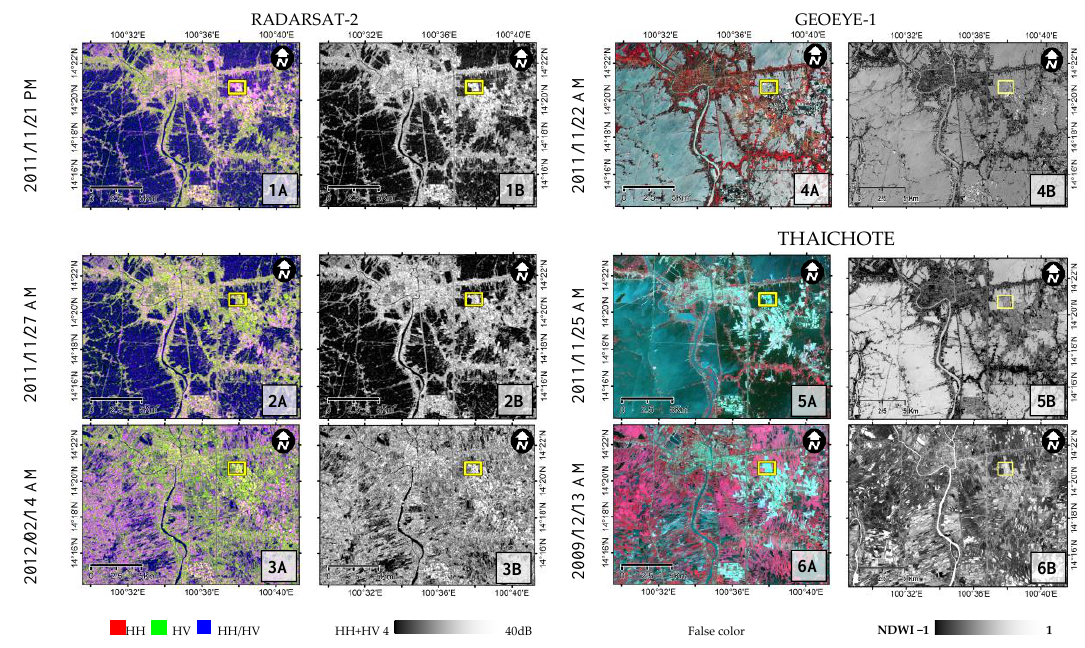
Figure 8. Close-up of Ayutthaya city for in-flood and post-flood time. The dual polarization color composite ( 1A – 3A ) and HH + HV ( 1B – 3B ) from RADARSAT-2. The false color composite and NDWI ( 4A , 4B ) from GeoEye-1, and the false color composite and NDWI for in-flood ( 5A , 5B ) and pre-flood ( 6A , 6B ) times from ThaiChote-1.